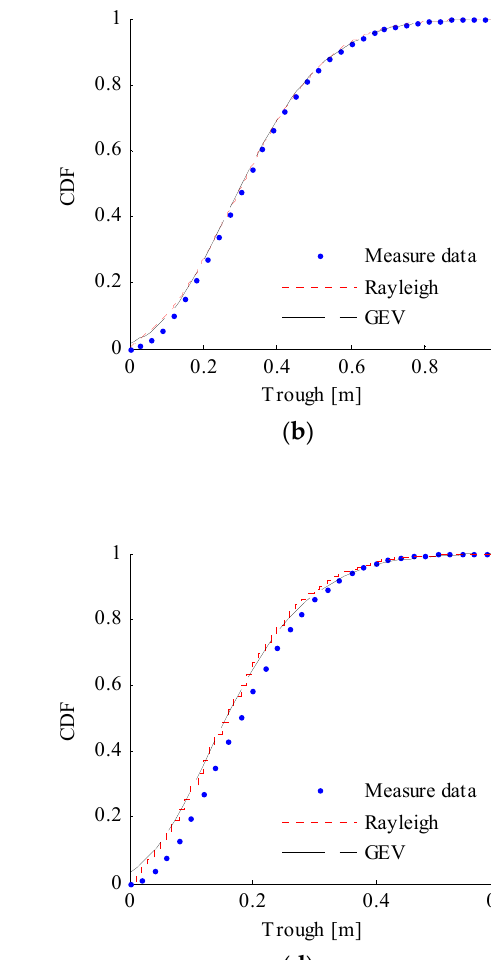
Figure 11. Computed probability density function (PDF) and cumulative distribution function (CDF) for the crest height of the measured data, and the Rayleigh and general extreme value (GEV) distributions: ( a ) crest height PDF when H s = 1.0583 m; ( b ) crest height CDF when H s = 1.0583 m; ( c ) crest height PDF when H s = 0.6069 m; and, ( d ) crest height CDF when H s = 0.6069 m.